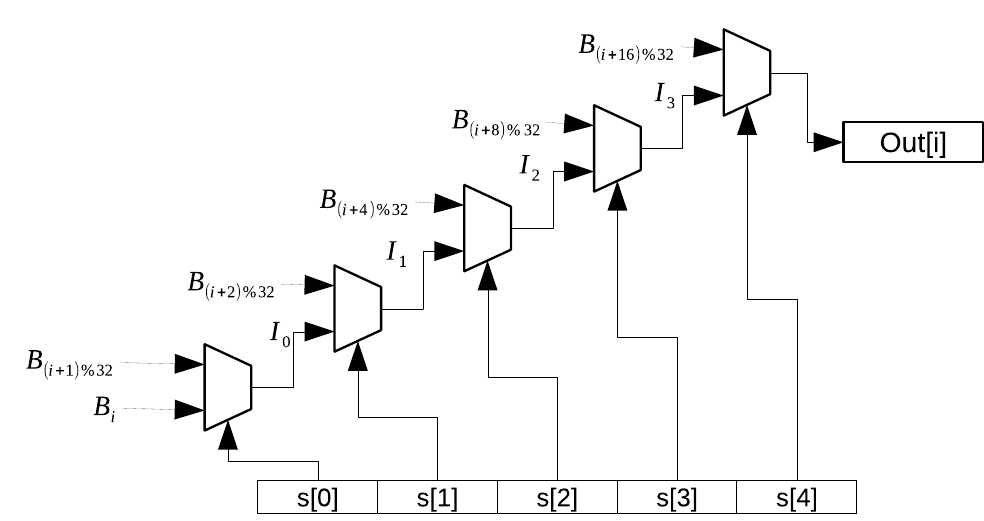
Figure 2: Logic function for a single output bit of a 32-bit wide barrel shifter, as found in the ARM ALU. An input word B , is rotated by an amount s to produce a result Out . Note the intermediate nets I x at each stage of the